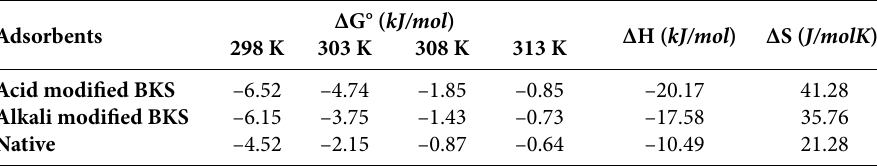
Table 7. Estimated Thermodynamic Parameters for As(III) ions adsorption